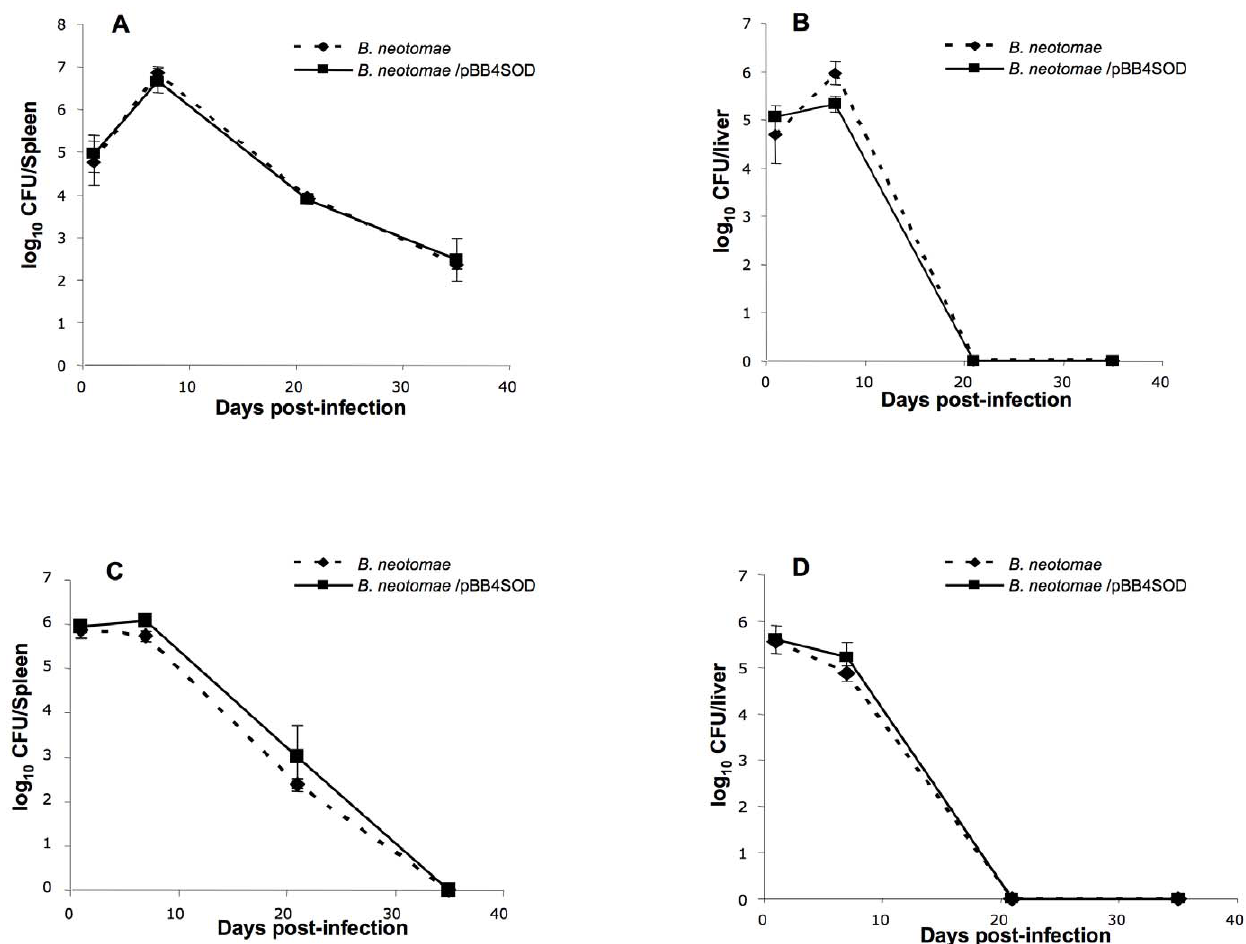
Figure 10. Colonization and persistence of B.neotomae and B.neotomae /pBB4SOD in spleens (A and C) and livers (B and D) of female, BALB/c (A and B) and C57BL/6 (C and D) mice. Mice were infected with the bacteria as described in Materials and Methods, and at each time-point, three mice from each group were euthanized and the bacterial burden in their spleens and livers was determined. Results are shown as the mean 6 standard deviation of log 10 CFU per organ. At each time-point there was no significant difference between the two groups ( P .